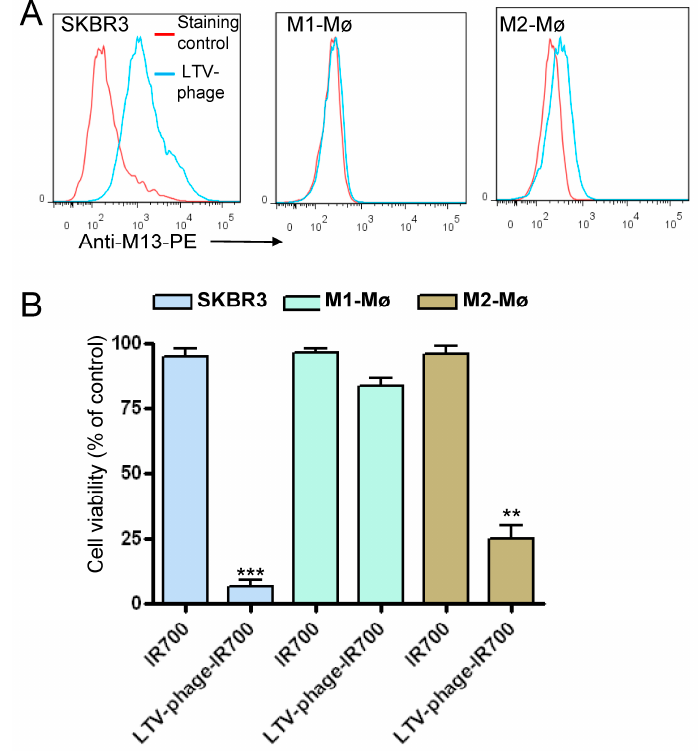
Figure 10. Dual targeting with the LTV phage-IR700 conjugate. ( A ) Representative histograms showing the binding of the phage displaying the LTV peptide to breast cancer cell line SKBR3, M1 and M2 macrophages. Cells were incubated with the phage particles (10 7 TU/mL, with approximately 3800 IR700 molecules/phage) and then analyzed by flow cytometry. Binding was detected using PE conjugated anti-M13 monoclonal antibody. ( B ) Photocytotoxicity of the LTV-phage-IR700 conjugate on SKBR3 breast cancer cell line, M1 and M2 macrophages was measured by MTS assay. Experimental conditions are as in Figure 9. ** p < 0.02, *** p < 0.001.